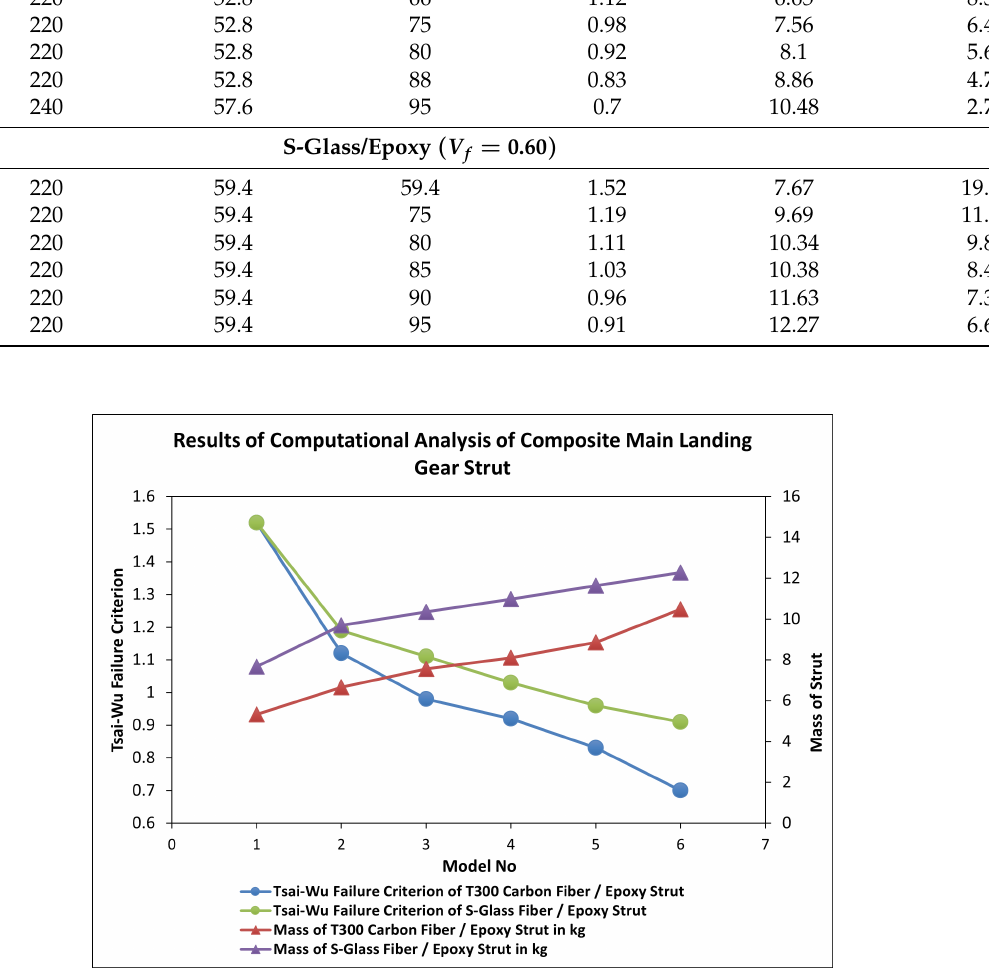
Figure 9. Variation of Tsai-Wu failure criterion factor and mass of the strut for T300 carbon fiber/epoxy and S-glass fiber/epoxy